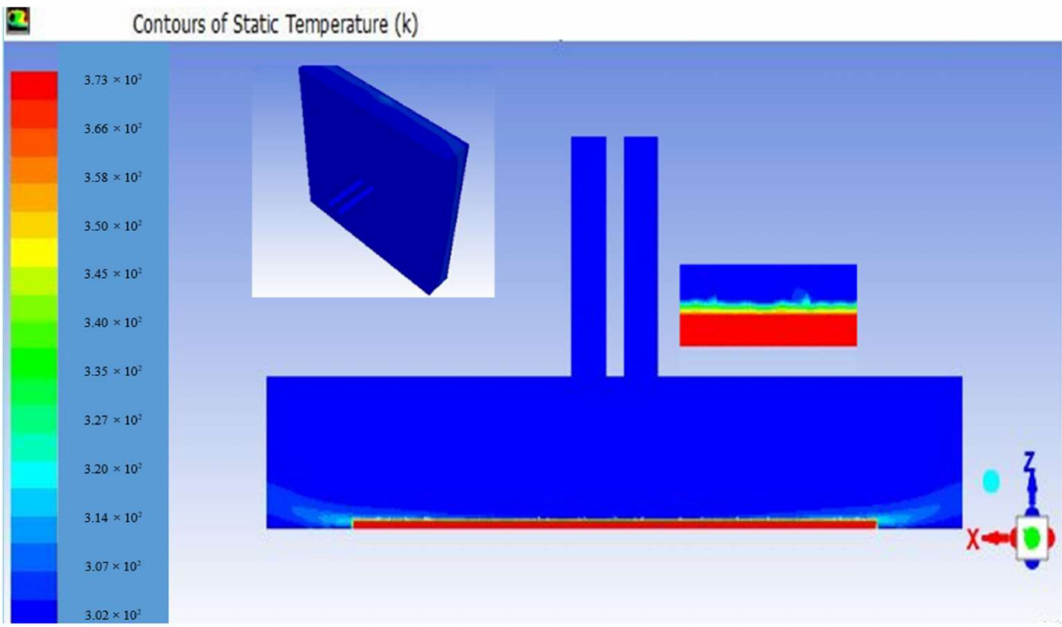
Figure 15. Static temperature contours of the twin jets impingement on the aluminum hot plate at S = 1 cm and H = 6